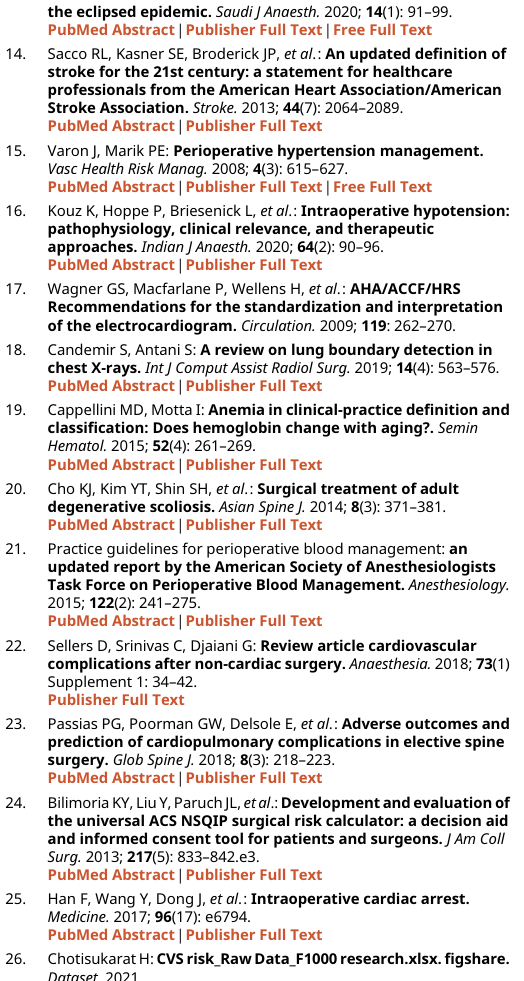
Figshare. CVS risk_Raw Data_F1000 research.xlsx. DOI: https://doi.org/10.6084/m9.figshare.16923355. 26